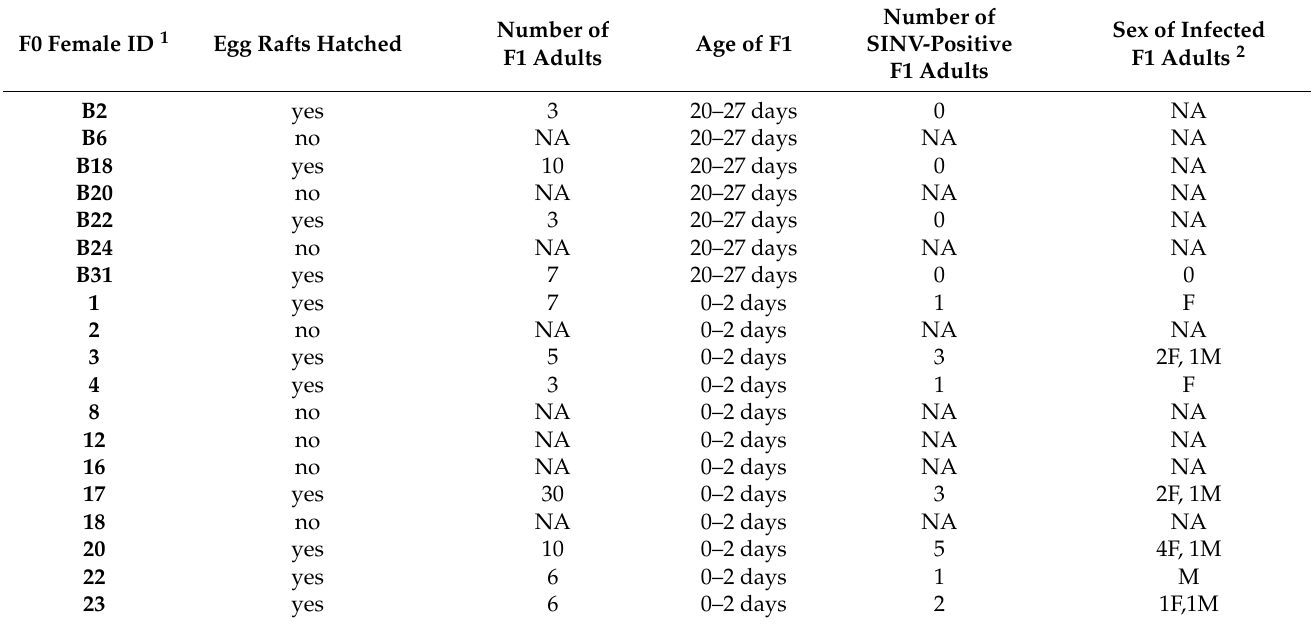
Table 1. Individually kept Culex pipiens molestus females that were confirmed to be infected by SINV and laid eggs.